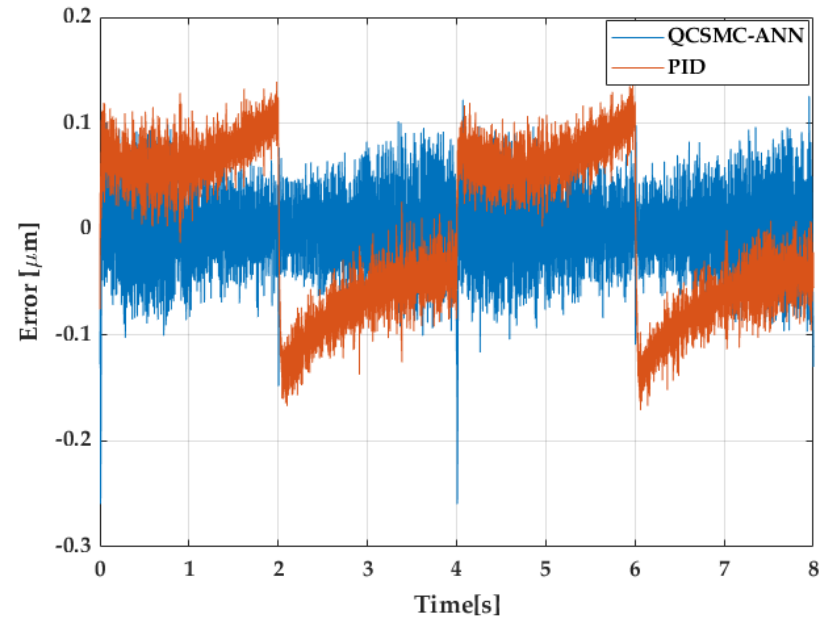
Figure 6. The error generated in 2 cycles of a triangular